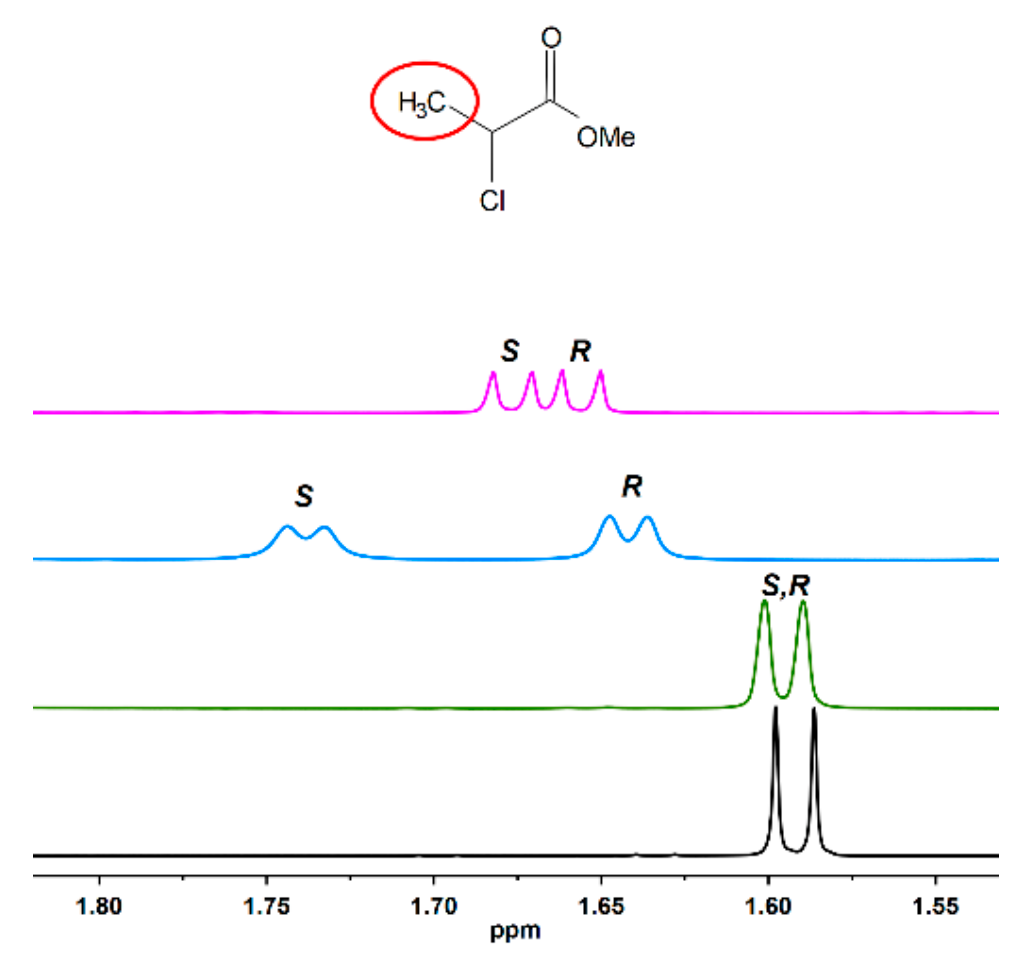
Figure 3. Expansions of 1 H NMR (600 MHz, C 6 D 12 , 25 °C) spectra of ( R , S )-MCP (20 mM) alone (black) and in a 1:1 mixture with AcSiCD6 (green), AcSiCD7 (blue), and AcSiCD8 (magenta), respectively. Table 2. Equimolar mixtures of MCP (20 mM) with AcSiCD6, AcSiCD7, or AcSiCD8 (600 MHz, C 6 D 12 , 25 °C): non-equivalences ( ǀ δ R − δ S ǀ , ppm) and complexation shifts ( Δ δ = δ mix – δ free , ppm) measured for the methyl group of MCP; bound molar fractions (x b ) and association constants (K, M − 1 ) obtained from diffusion